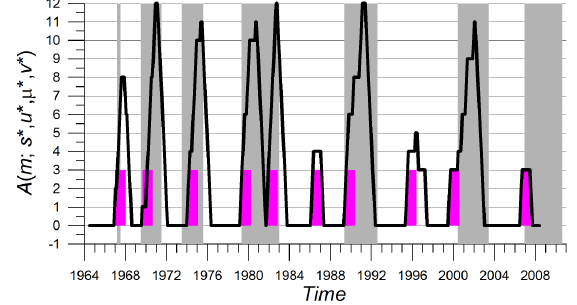
Fig. 16. The graph of the activity-level function A(m ; s ∗ , u ∗ , µ ∗ , v ∗ ) for the prediction of US economic recessions. Parameter values are (s ∗ ,u ∗ ,µ ∗ ,v ∗ ) = ( 6 , 48 , 0 . 4 , 12 ) and they were calculated from the Federal Reserve Bank of St. Louis (FRBSL) monthly series of industrial production total (IPT; black curve). Official economic recessions in the US are shown as grey strips, and alarms declared by the algorithm as magenta bars of duration τ = 12 months; see Sect. 7.2.3 and Appendix D for details.